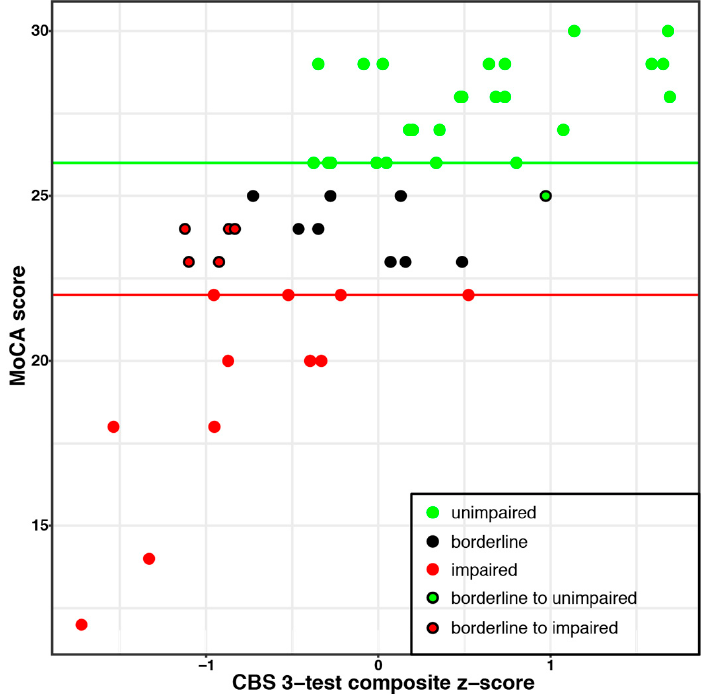
Figure 3. The CBS composite score was highly correlated with Montreal Cognitive Assessment (MoCA) scores and better differentiated impaired and unimpaired individuals. The border colour of each datapoint indicates the categorization of individuals based on MoCA scores alone. The fill colour indicates to which group borderline participants are categorized when the composite score of 3 CBS tests is used.